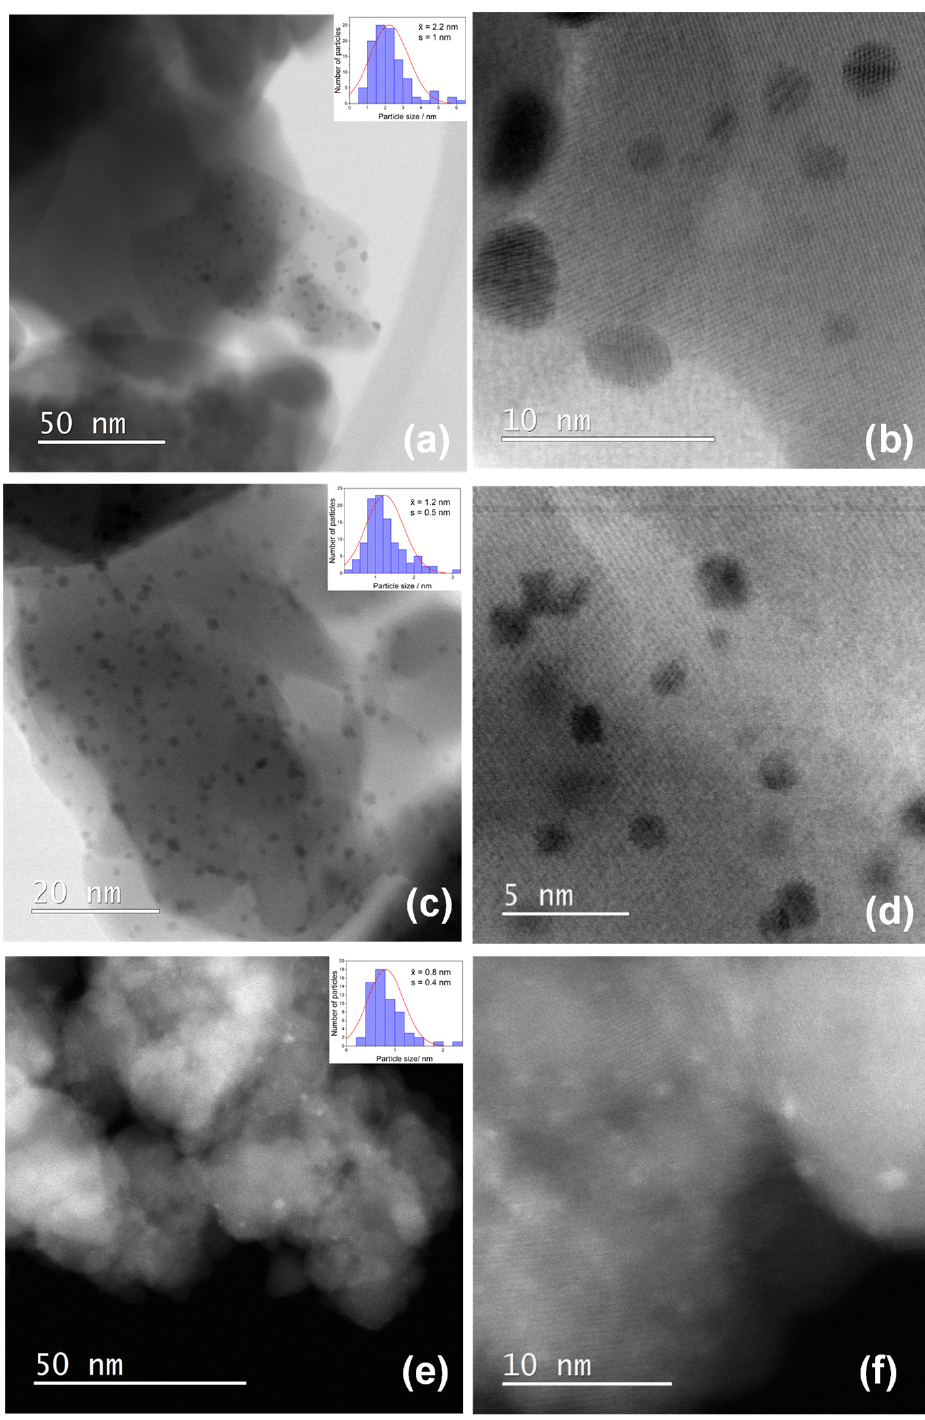
Figure 6. STEM bright-field images and particle size distributions (inset) of samples FE-1 at low magnification ( a ) and at high magnification ( b ); STEM bright-field images and particle size distributions (inset) of samples FE-2 at low magnification ( c ) and at high magnification ( d ); STEM dark-field images and particle size distributions (inset) of samples FE-3 at low magnification ( e ) and at high magnification ( f ).